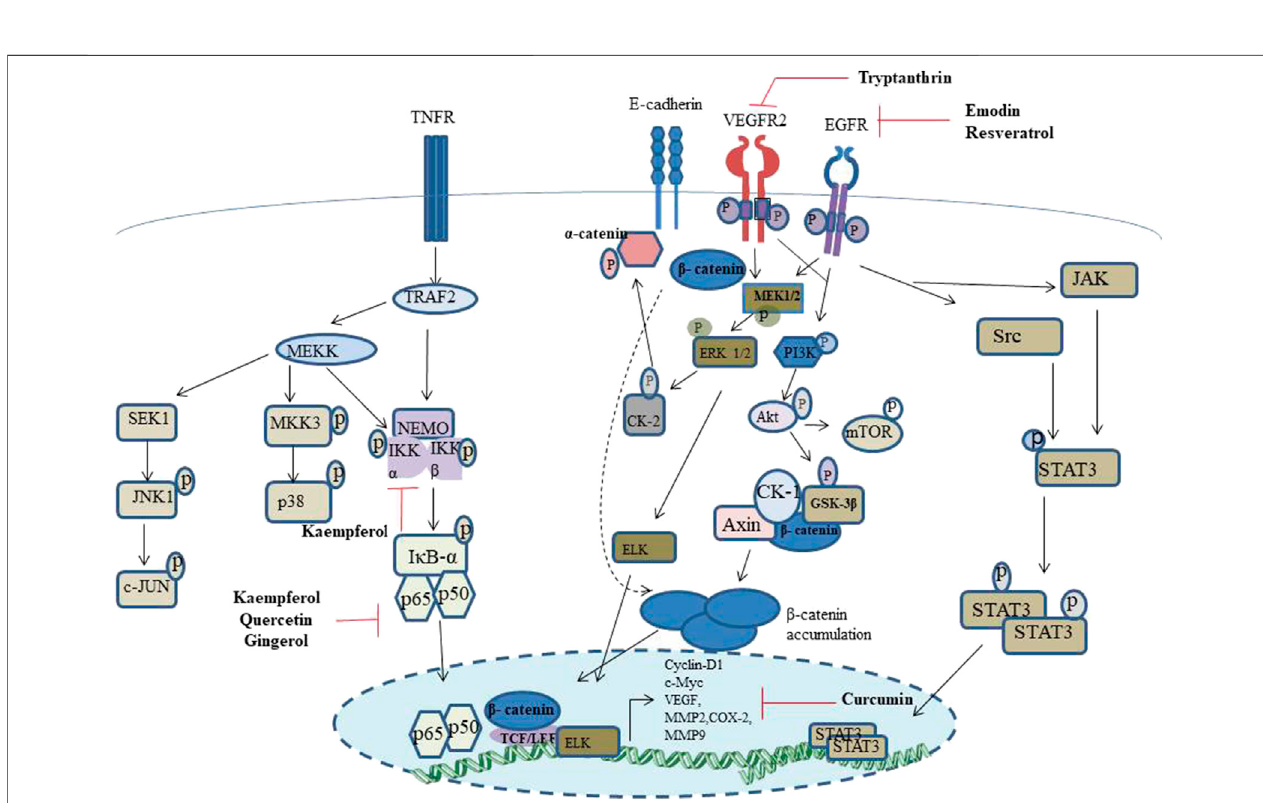
FIGURE 5 | Schematic representation of the major signalling events regulated by the phytochemicals discussed in the current report.